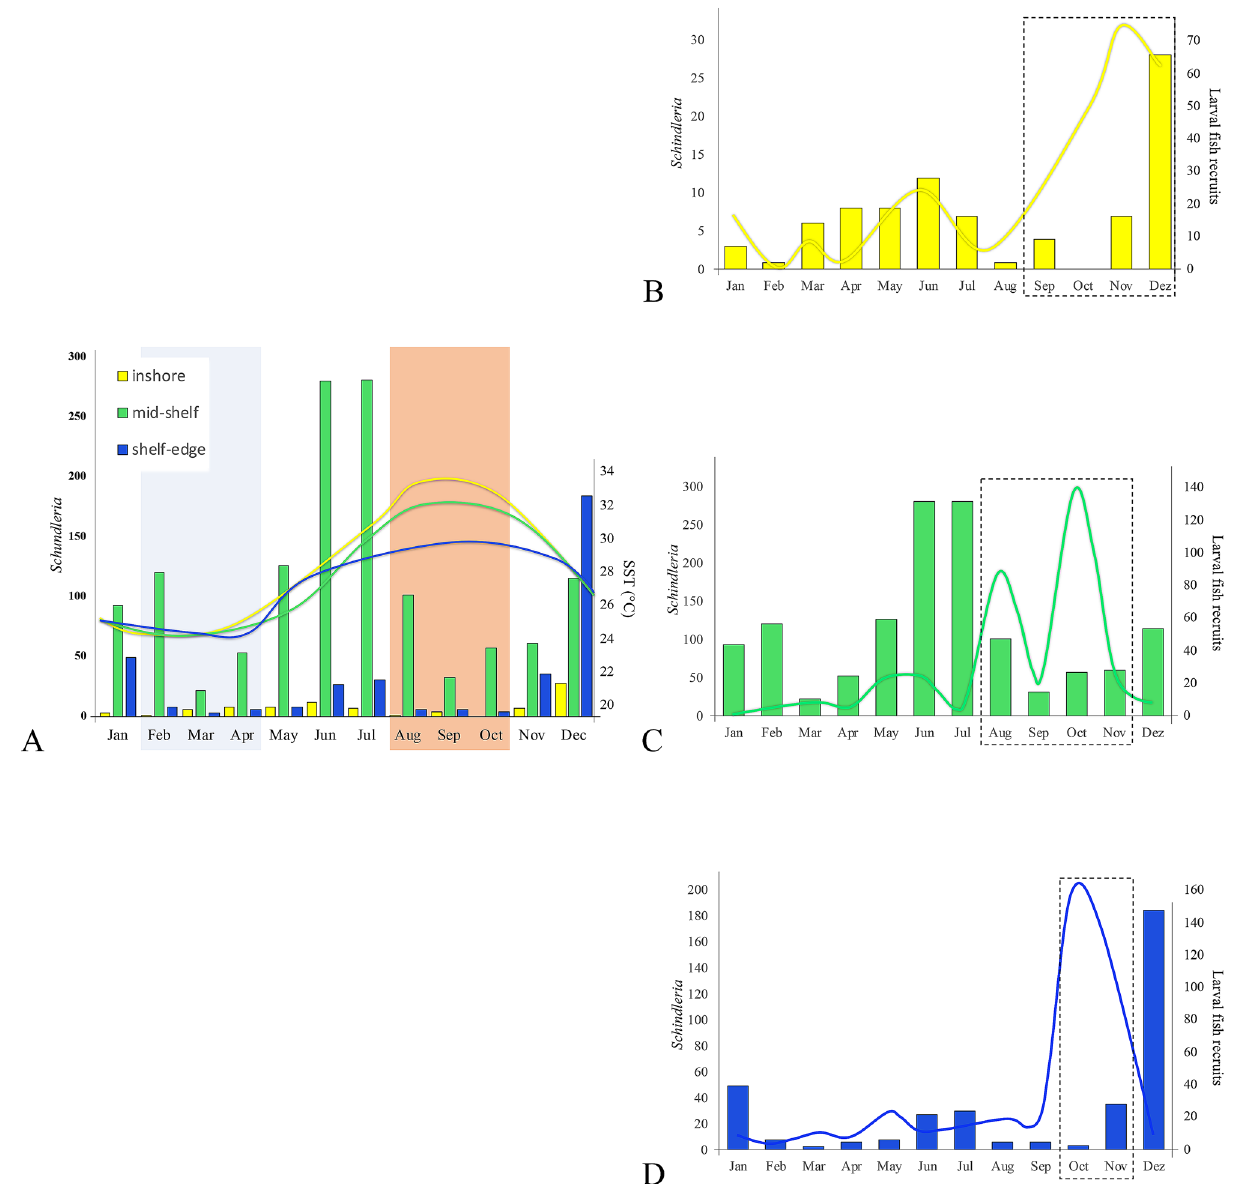
Figure 6. Barplot of the year-round abundances of adult LDF Schindleria (y-axis) from the Red Sea (Thuwal, Saudi Arabia) caught with LED powered light traps (monthly, during five days around the new moon, from February 2015 to January 2016) at three different reefs along a cross-shelf gradient: one inshore (“yellow”), one at the mid-shelf (“green”), and one at the shelf edge (“blue”). Panel A: adult LDF Schindleria abundances in relation to sea surface temperatures (SST, in °C). The total number of individuals for each sampling site collected each month is given as vertical bars (values correspond to the y-axis to the left). Temperature (SST) profiles per reef are also color-coded and given as a continuous line (values correspond to y-axis to the right). A “light-blue” shaded box indicates the months with temperature minima (February to April) and an “orange” shaded box indicates the months with temperature maxima (August to October), representing the hottest and coldest seasons, following Robitzch et al. 35 . Peaks of abundances are observed outside both boxes. Panel ( B ) to ( D ): adult LDF Schindleria abundances in relation to the abundance of larval fish recruits from light trap collections 35 , color-coded per reef site as in Panel ( A ). The total number of adult LDF Schindleria individuals collected at each sampling site is given by vertical lines and their values correspond to the left y-axis. Profiles of the abundances of larval fish recruits are given by continuous lines and their scale is given by the right y-axis. Dashed boxes indicate the months with peaks in recruitment of coral reef fish larvae (sensu Robitzch et al. 35 ). Peaks of abundances of adult LDF Schindleria do not generally coincide with peaks of larval fish